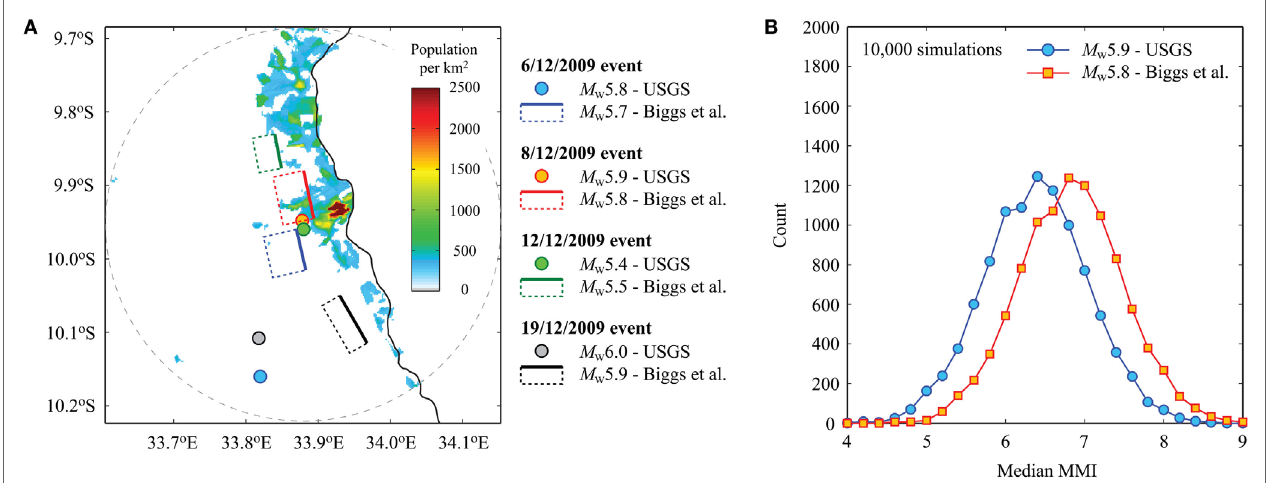
FigUre 8 | (a) Population distribution in Karonga (the radius is extended to 30 km) and source models of the 2009 Karonga earthquake sequence by United States Geological Survey (2009) and Biggs et al. (2010). (B) Histograms of median MMI for the 2009 Karonga earthquake scenario based on source models by United States Geological Survey (2009) and Biggs et al.